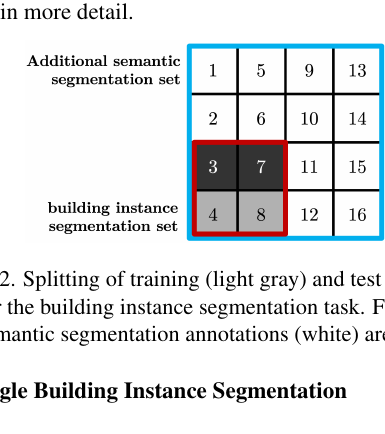
Figure 3. Various kinds of buildings included in the benchmark: residential buildings, detached houses, and Z´enith Toulouse M´etropole (from left to right).